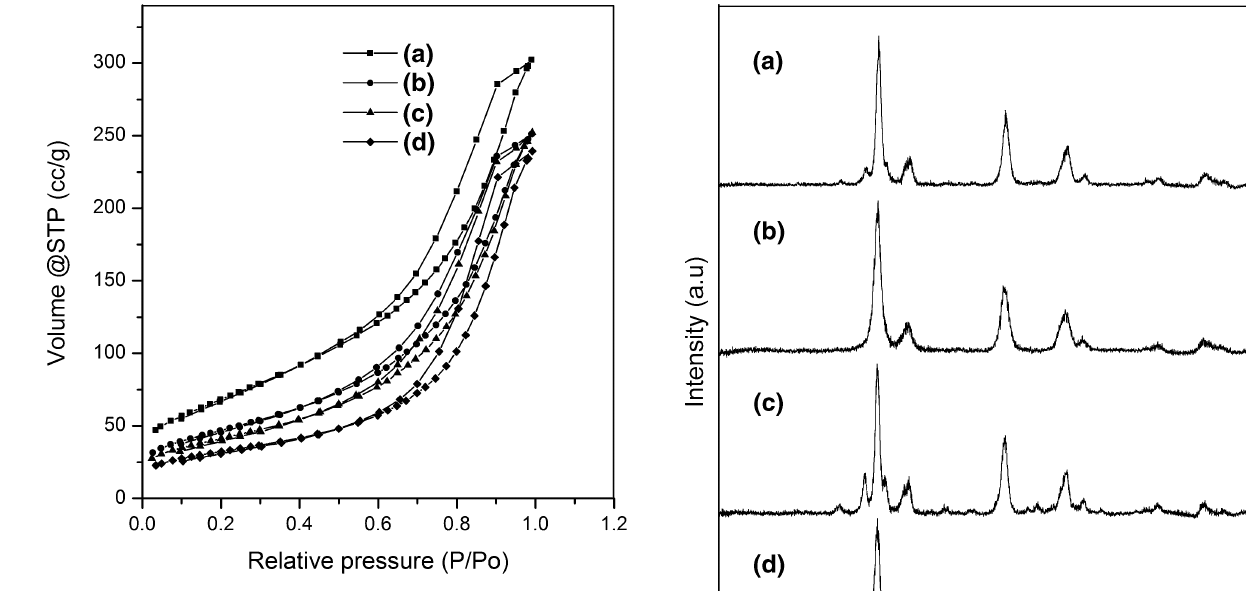
Fig. 4 Isotherm adsorption–desorption of catalysts calcined at var- ious temperatures: a 400 (cid:3) C, b 500 (cid:3) C, c 600 (cid:3) C, and d 700 (cid:3) C